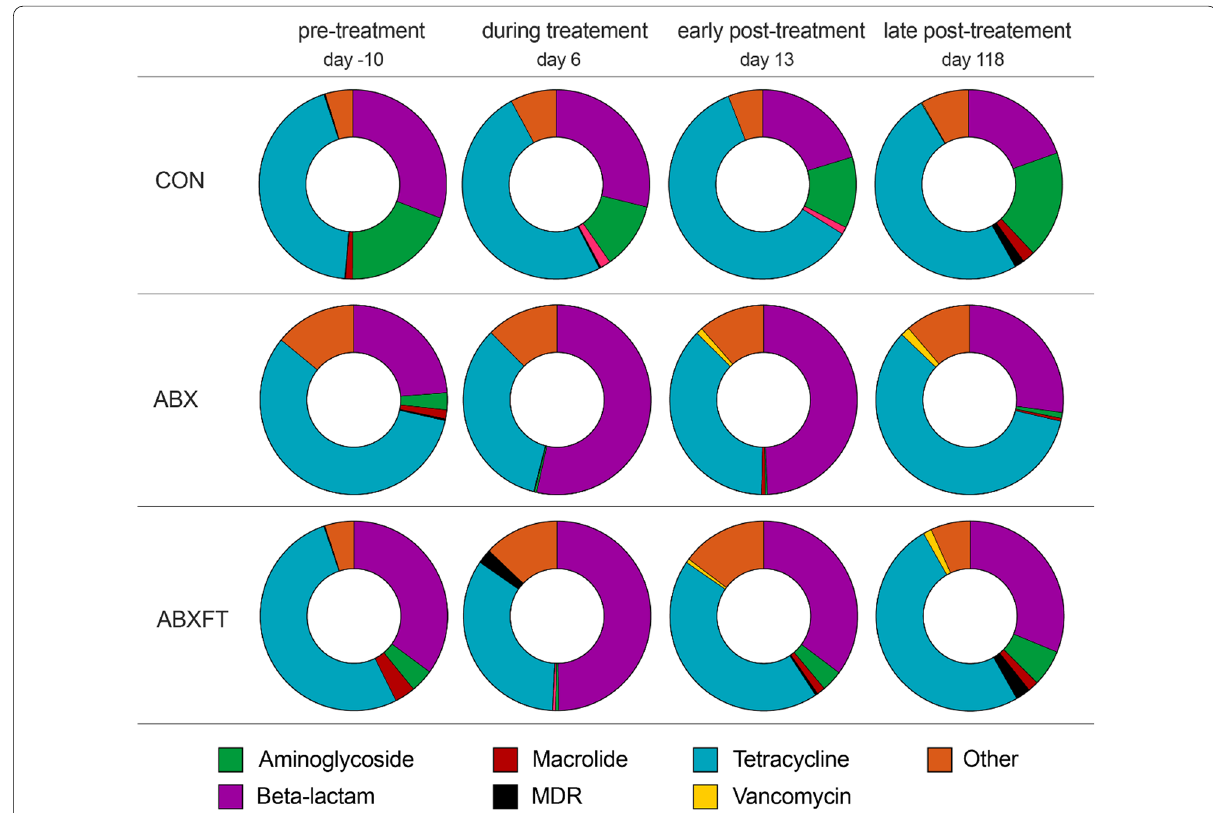
Fig. 7 Proportions of antibiotic resistance (ABR) genes identified in healthy, male ring‑tailed lemurs ( Lemur catta ) that received no treatment (CON), antibiotics only (ABX), or antibiotics plus fecal transfaunation (ABXFT). Shown are color‑coded resistance gene families at four time points during the study, during which antibiotic treatment was administered on days 0–6 and fecal transfaunation was administered on day 7. MDR Resistant